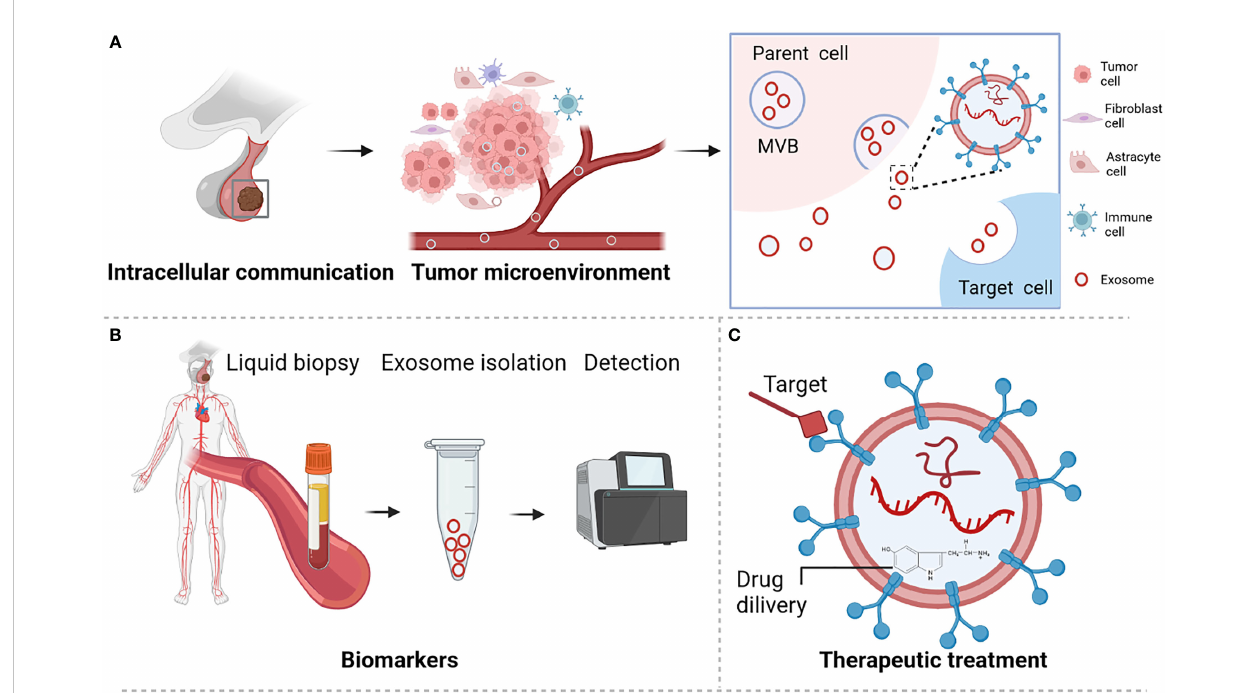
FIGURE 1 Role and functions of exosome in pituitary adenoma. (A) Exosome participates in microenvironment regulation and cell communication. (B) Exosome served as biomarker for PA disease. (C) Exosome is a promising novel treatment therapy. Figures are created in